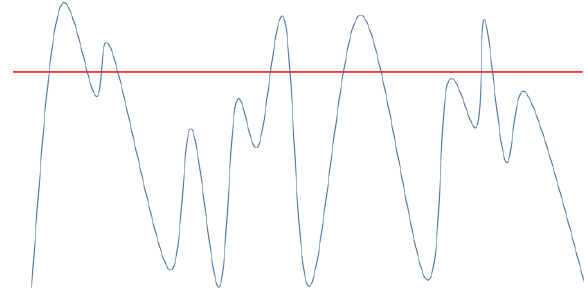
Figure 7. Steps being counted incorrectly when using one threshold.